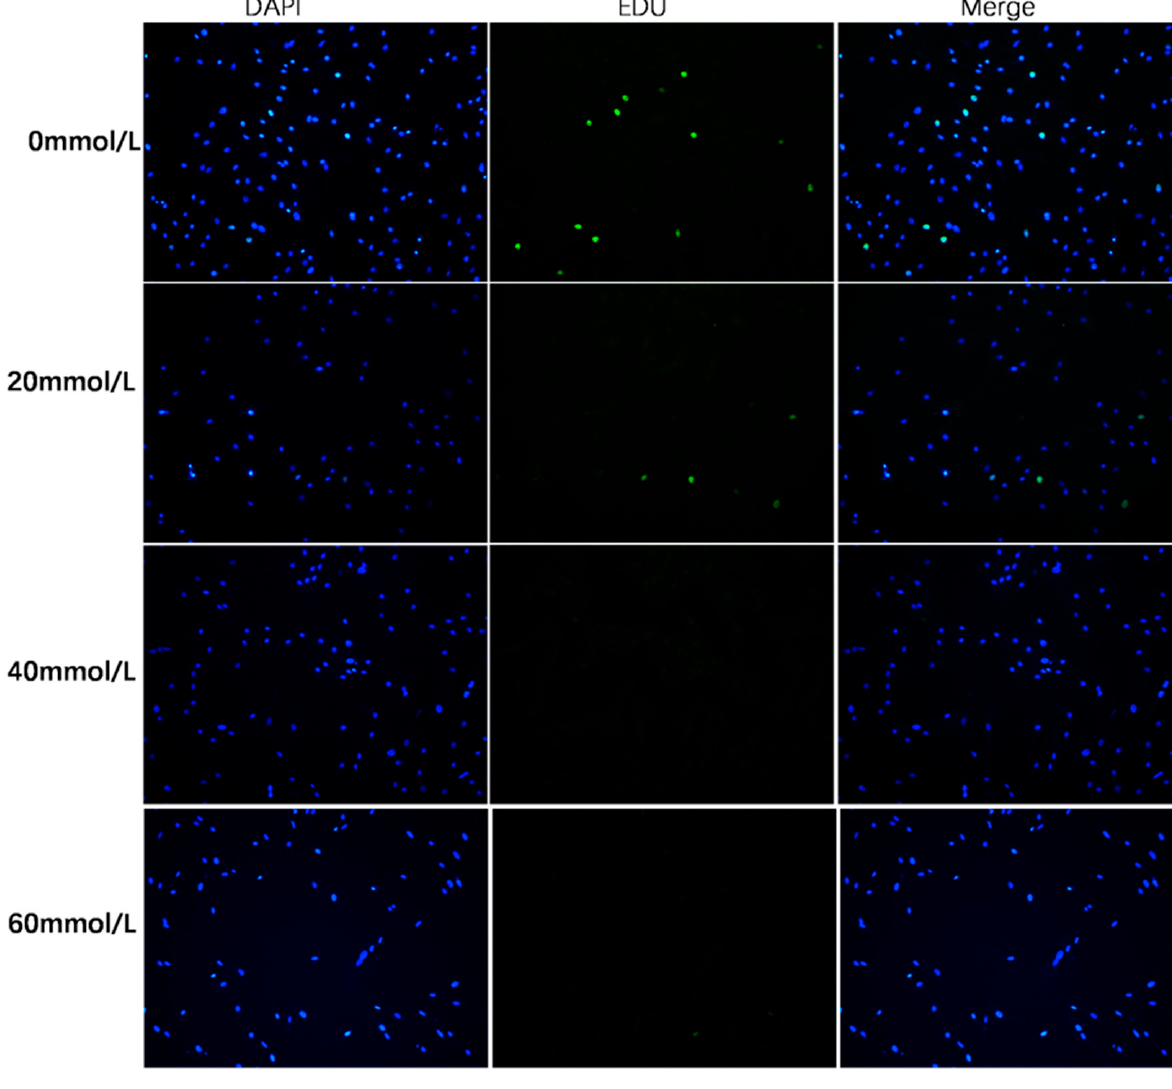
Figure 4. The detection of pGC proliferation by fluorescence microscopy. Following a 24-h treatment with different doses of 2,5-HD (0 mmol/L, 20 mmol/L, 40 mmol/L and 60 mmol/L), the proliferation of pGCs was assessed using an EDU assay. DAPI was used to color the cell nuclei blue, and EDU- positive cells were colored green. Scale bar 200 µm.